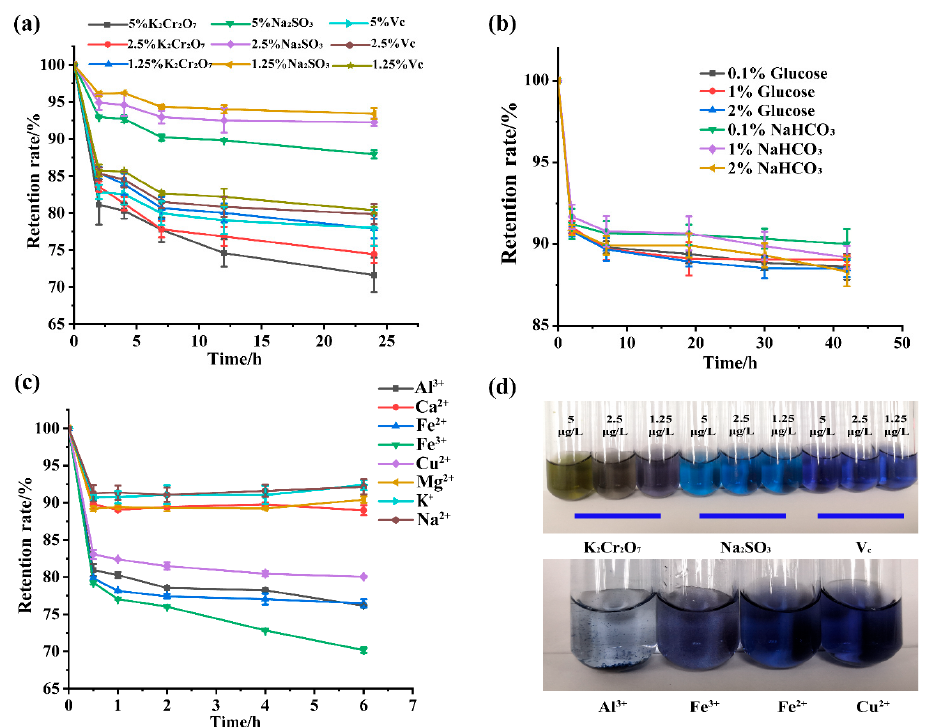
Figure 5. ( a ) Varying concentrations of oxidant and reductant decreased the retention rate of GBP. ( b ) Varying concentrations of glucose and sodium bicarbonate reduced the retention rate of GBP. ( c ) The coexistence of various metal ions reduced the retention rate of GBP. ( d ) Schematic diagram of GBP degradation.